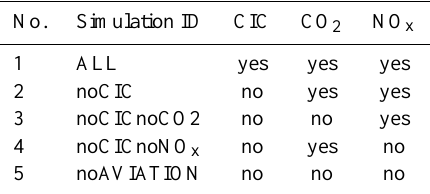
Table 1. Sensitivity simulations performed in the study, and iden- tification of aviation forcings. All sensitivity simulations have been performed over 1940–2100, with online